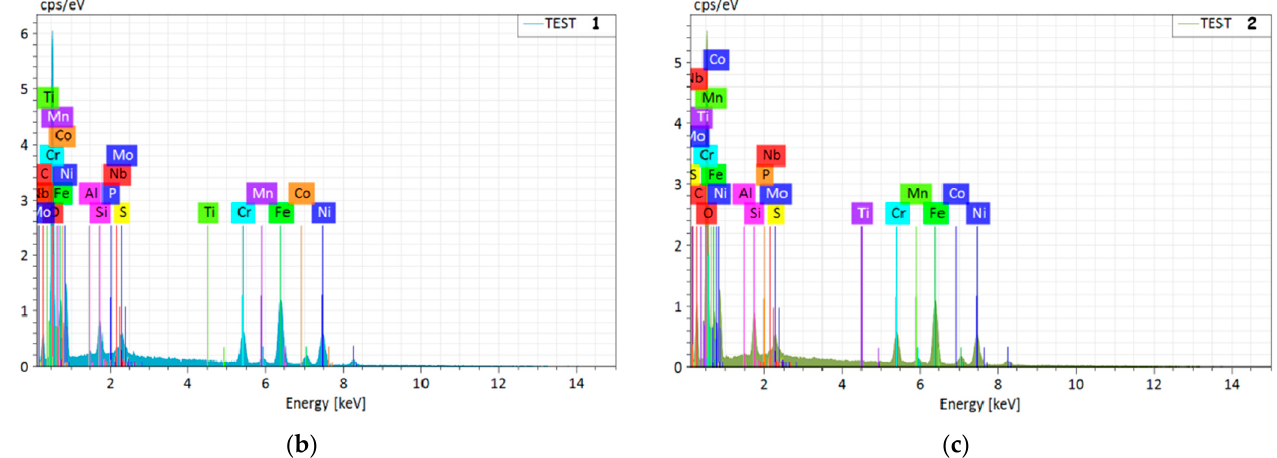
Figure 13. Ni-based EDS spot scan. ( a ) The image of Ni-based interface at 200 μ m of the scale.; ( b ) The EDS image of Test 1; ( c ) The EDS image of Test 2. From Figure 14, two points in the dark gray area were taken for the EDS analysis. Table 8. Ni-based EDS spot scan of atoms for each element content (wt%).